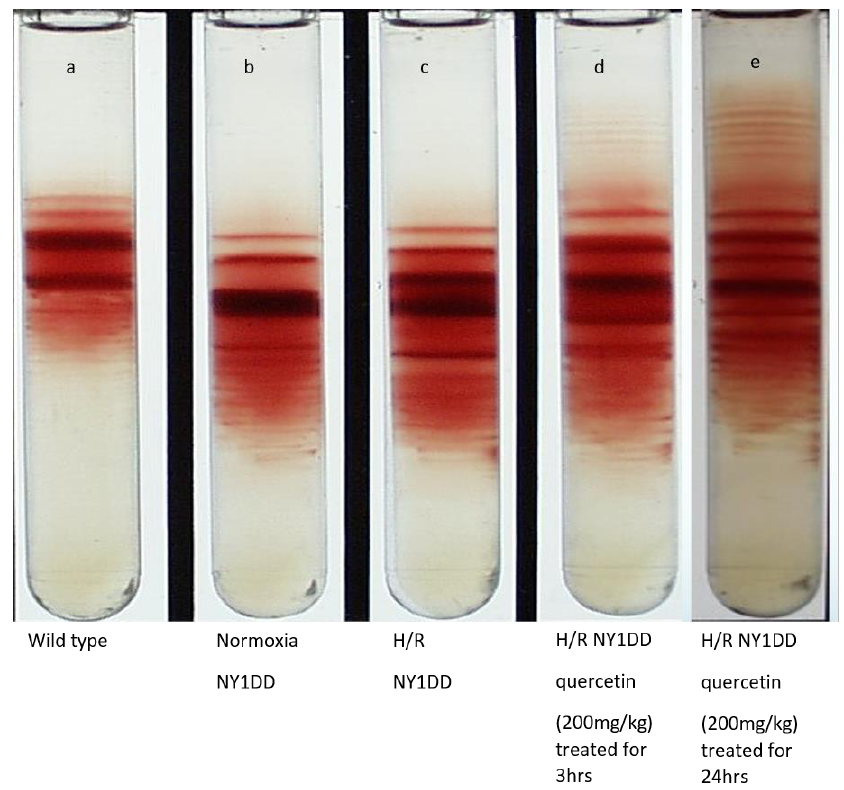
Figure 8. Effect of quercetin on red cell density pattern of wild type and NY1DD under normoxia and hypoxia condition; ( a ) wild type control mice; ( b ) normoxia NY1DD mice; ( c ) H/R-induced NY1DD mice; ( d ) H/R-induced NY1DD mice treated with quercetin (200 mg/kg) for 3 h; ( e ) H/R-induced NY1DD mice treated with quercetin (200 mg/kg) for 24 h.